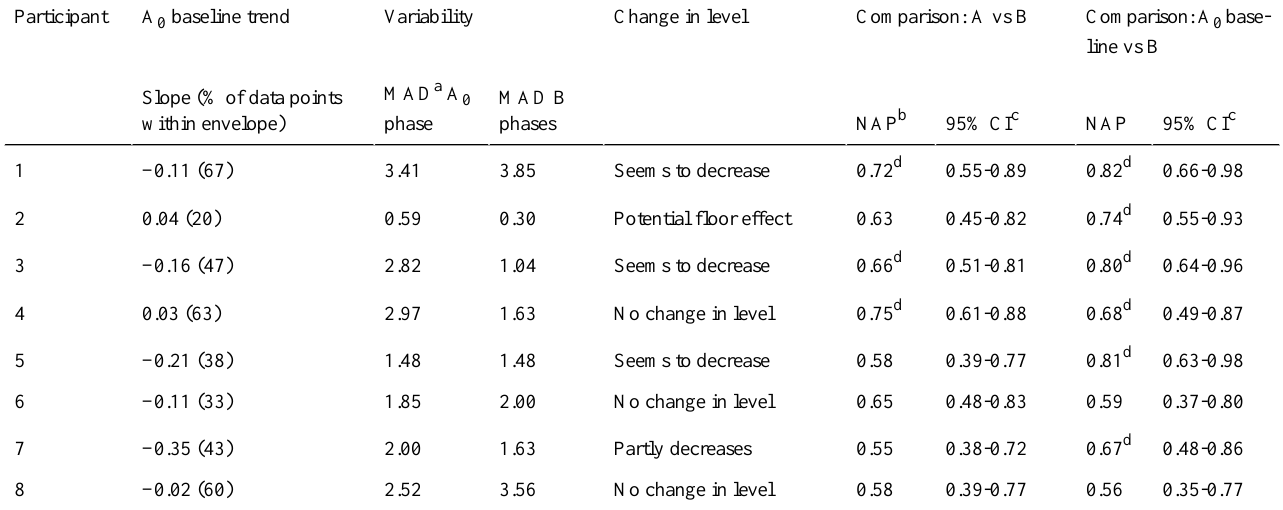
Table 4. Results from visual analysis (baseline trend, variability, and change in level) and nonoverlap of all pairs on anxiety.